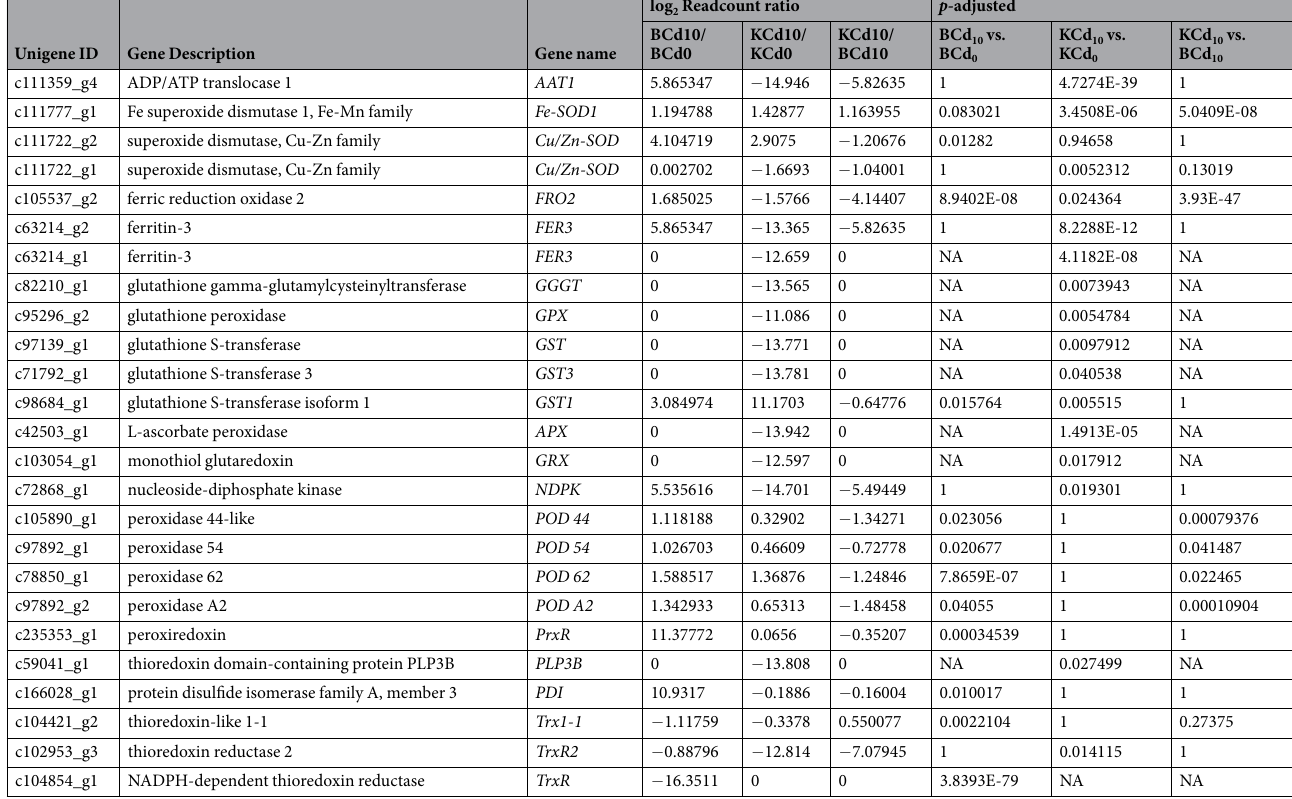
Table 2. The identified candidate genes involved in ROS scavenging system in response to Cd exposure in pak